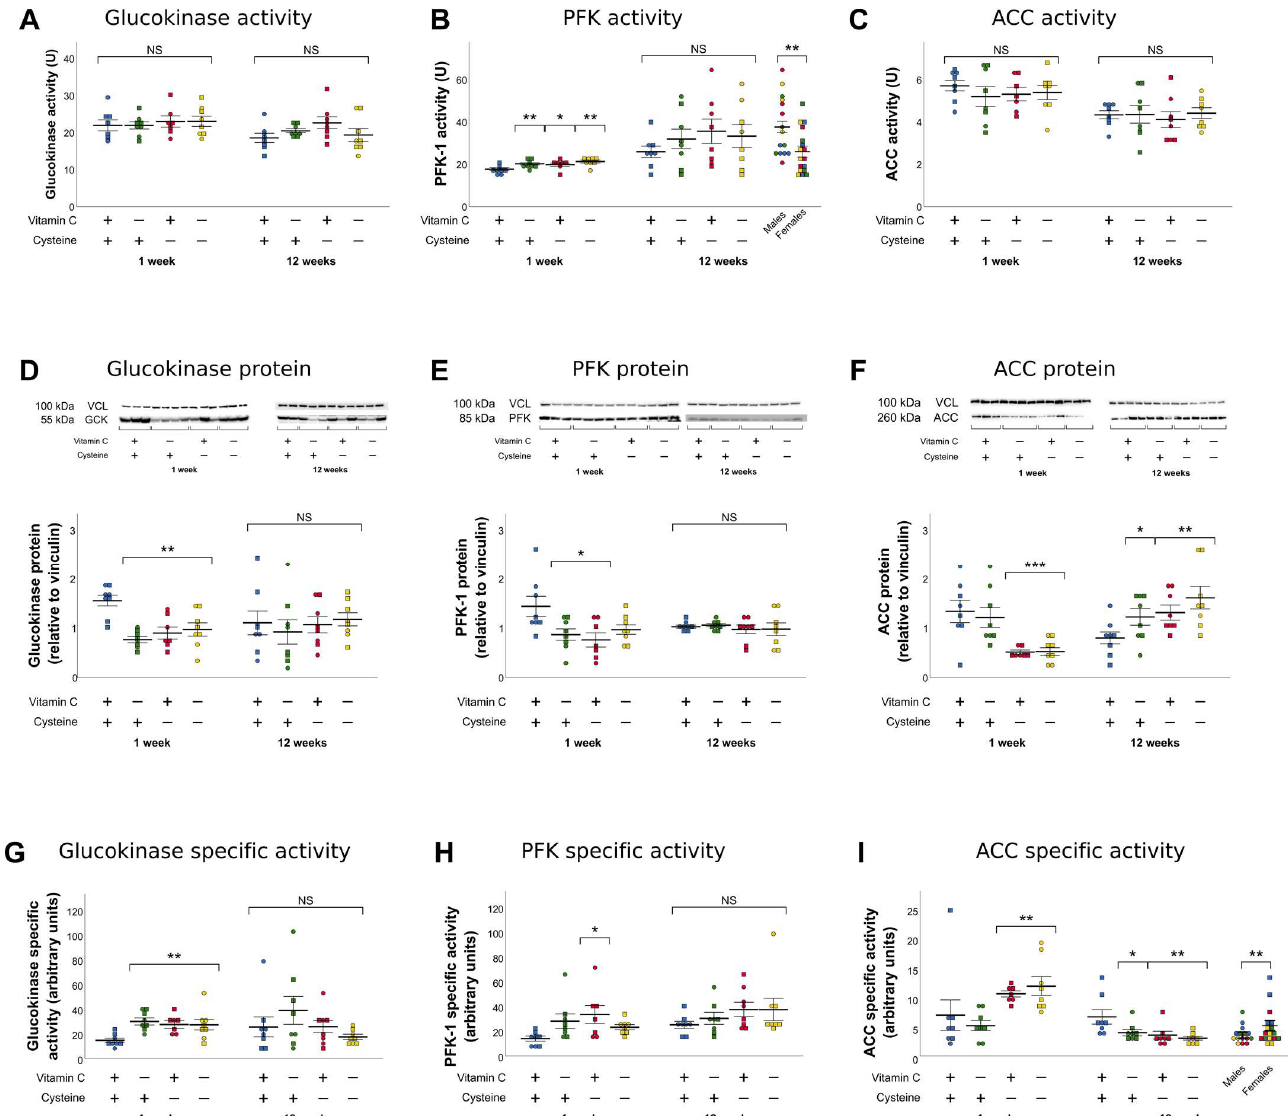
Figure 5. Hepatic activity, protein levels, and specific activity of glucokinase (GCK), phosphofructokinase (PFK), and acetyl-CoA-carboxylase (ACC) in 1-week-old and 12-week-old animals. ( A ). No statistically significant differences were observed in GCK activity either at 1 week of life or at 12 weeks. ( B ). At 1 week of life, PFK activity was significantly increased by vitamin C and cysteine deficiency. At 12 weeks, PFK activity was increased in males, compared to females. ( C ). ACC activity was not significantly affected either at 1 week or at 12 weeks. ( D ). The protein levels of GCK were decreased at 1 week by both vitamin C and cysteine deficiency. ( E ). PFK protein levels were decreased at 1 week by both vitamin C and cysteine deficiencies. ( F ). ACC protein levels at 1 week were decreased by cysteine deficiency. At 12 weeks, ACC protein levels were increased by both early-life vitamin C and cysteine deficiencies, with a further additive effect of the double deficiency. ( G ). At 1 week of life, GCK specific activity was increased by vitamin C and cysteine deficiencies. ( H ). At 1 week of life, PFK specific activity was increased in all deficient groups. ( I ). ACC specific activity at 1 week was increased in cysteine deficient animals. At 12 weeks, it was independently decreased in neonatal vitamin C and cysteine deficient animals, as well as in males. Mean ± SEM. Circles: male animals; squares: female animals; NS: statistically non-significant; *: p < 0.05; **: p < 0.01; ***: p < 0.001.